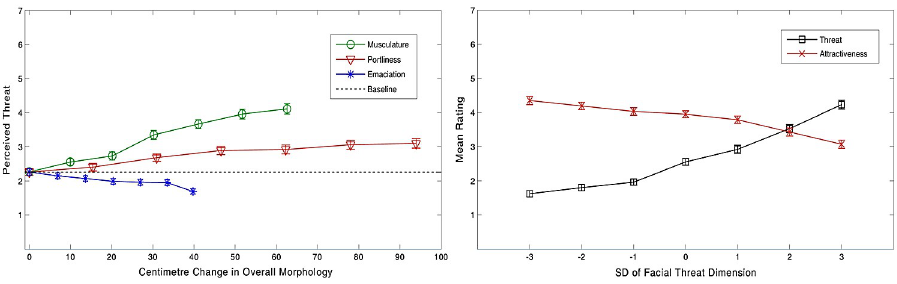
Fig 2. Mean perceived threat for each of the levels of body morphology manipulations by total centimetre change in morphology (left) and mean perceived threat and perceived attractiveness for each of the levels of facial dimension (right). Error bars represent standard